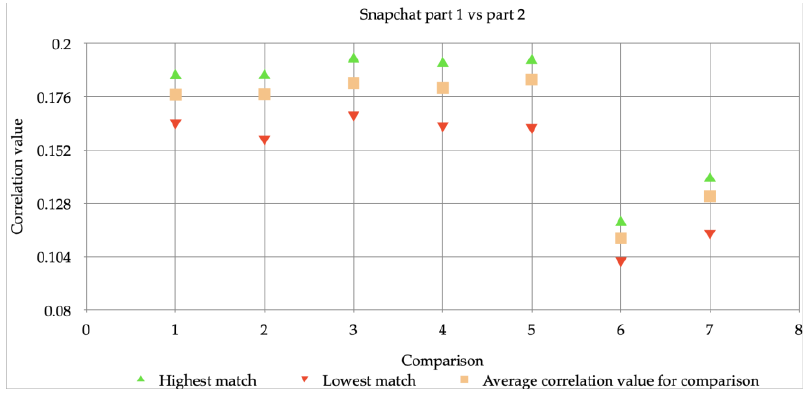
Figure 5. Mutual comparisons of Snapchat video’s (part 1) and Snapchat video’s (part